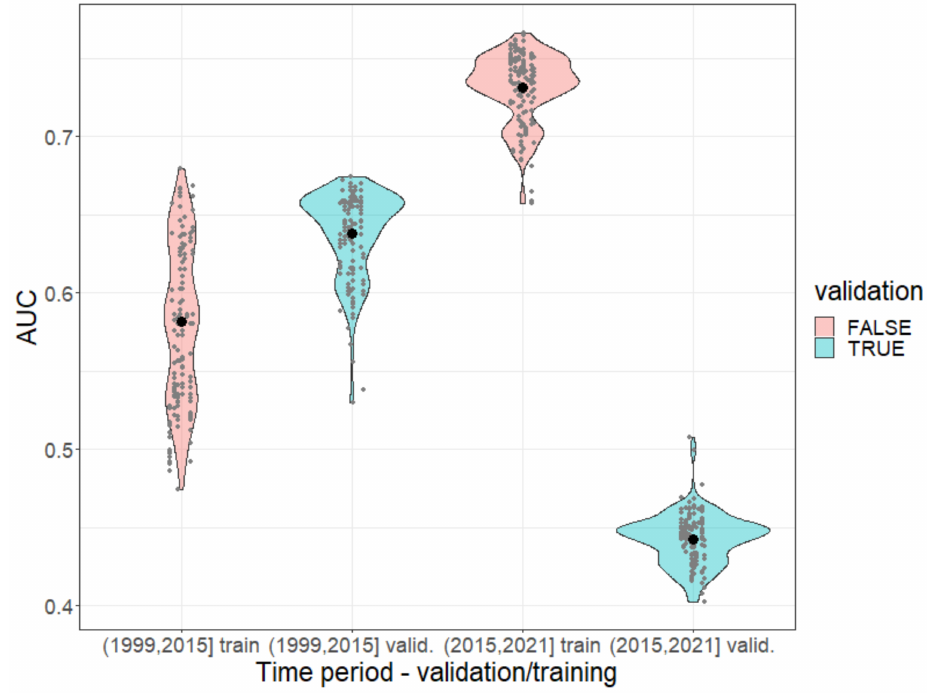
Figure A10. Evaluation of model predictions on training and validation data per time period. For two periods (2000–2015) and (2016–2021), we computed the AUC over all validation (resp. training) cells and years of the